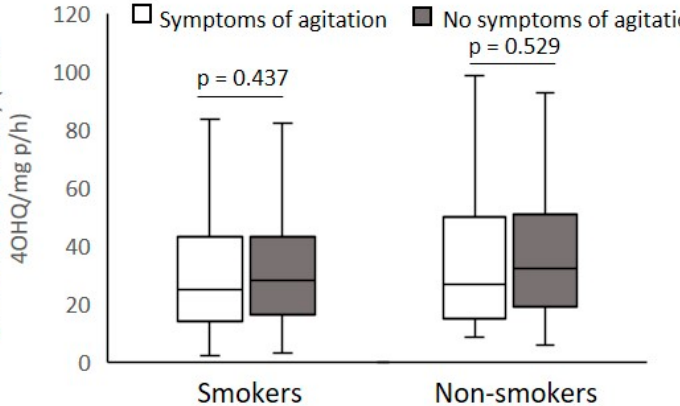
Figure 3. Platelet MAO-B activity in subjects with severe and mild symptoms evaluated by the PANSS-positive subscale, subdivided according to smoking status.